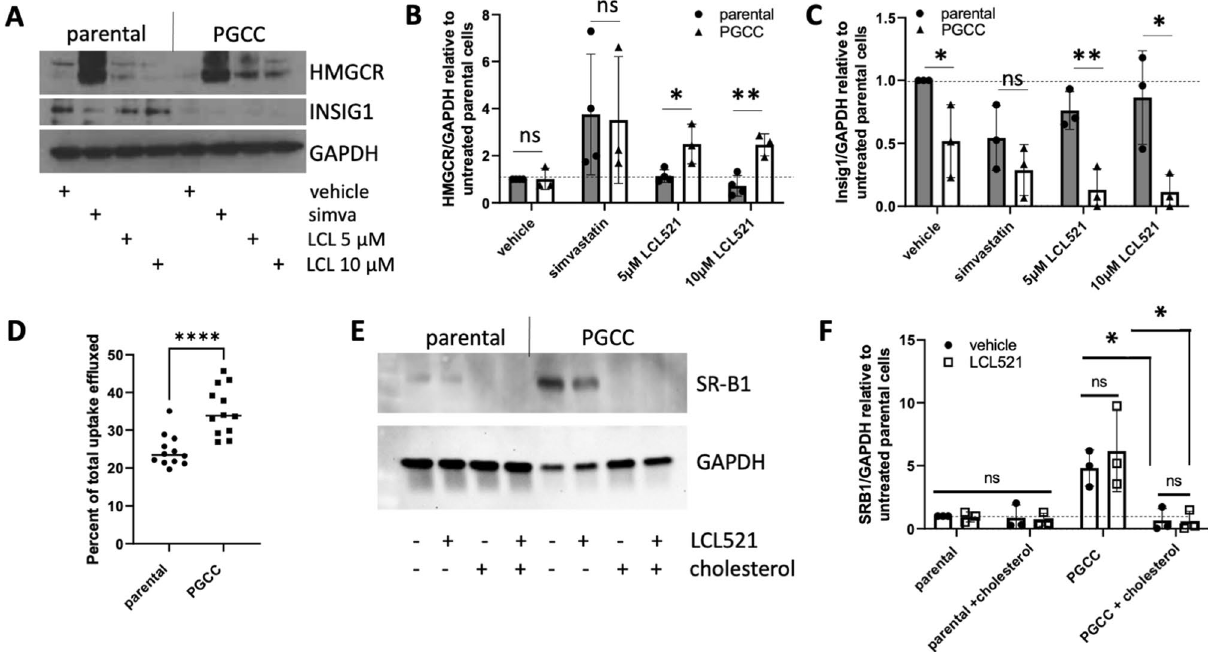
Figure 4. Cholesterol metabolism and trafficking in PGCC is upregulated. ( A ) Western blot analysis of HMCGR and INSIG1 after two days of treatment with 5 or 10 µM LCL521. Simvastatin (1 µM) was included as a positive control. Expression levels relative to GAPDH were calculated for both genes and normalized to untreated parental cells. Comparisons between parental and PGCC are shown for HMGCR ( B ) and INSIG1 ( C ), summarizing 3 or 4 independent experiments. ( D ) Quantification of cholesterol efflux, represented as percent released of total incorporated. ( E ) Western blot analysis of SR-B1, with 3 independent experiments quantified